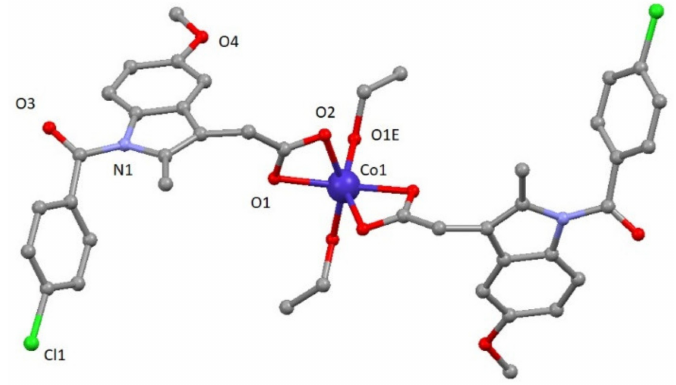
Figure 2. A perspective view on the molecular structure of [Co(ind) 2 (EtOH) 2 ] ( 3 ). Hydrogen atoms have been omitted for